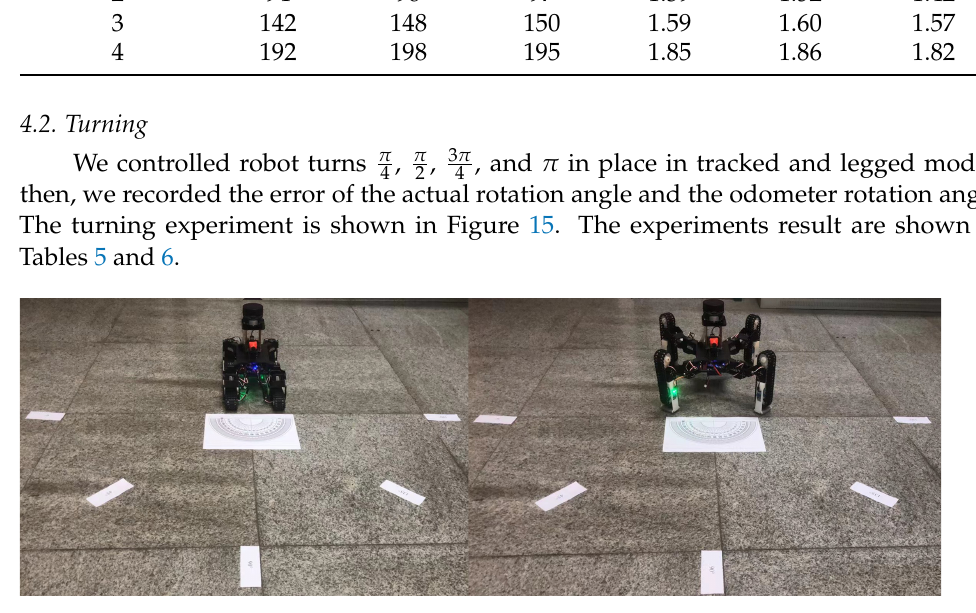
Figure 15. The turning experiment in tracked and legged